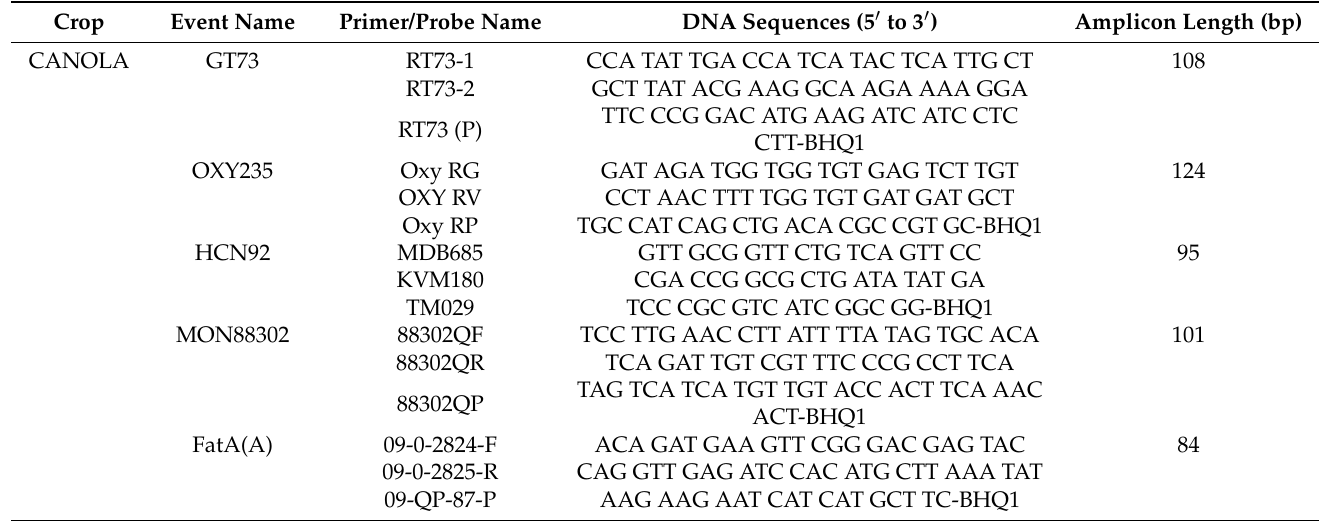
Table 1. Primer and probe DNA sequences used for absolute quantification of GM canola and soybean